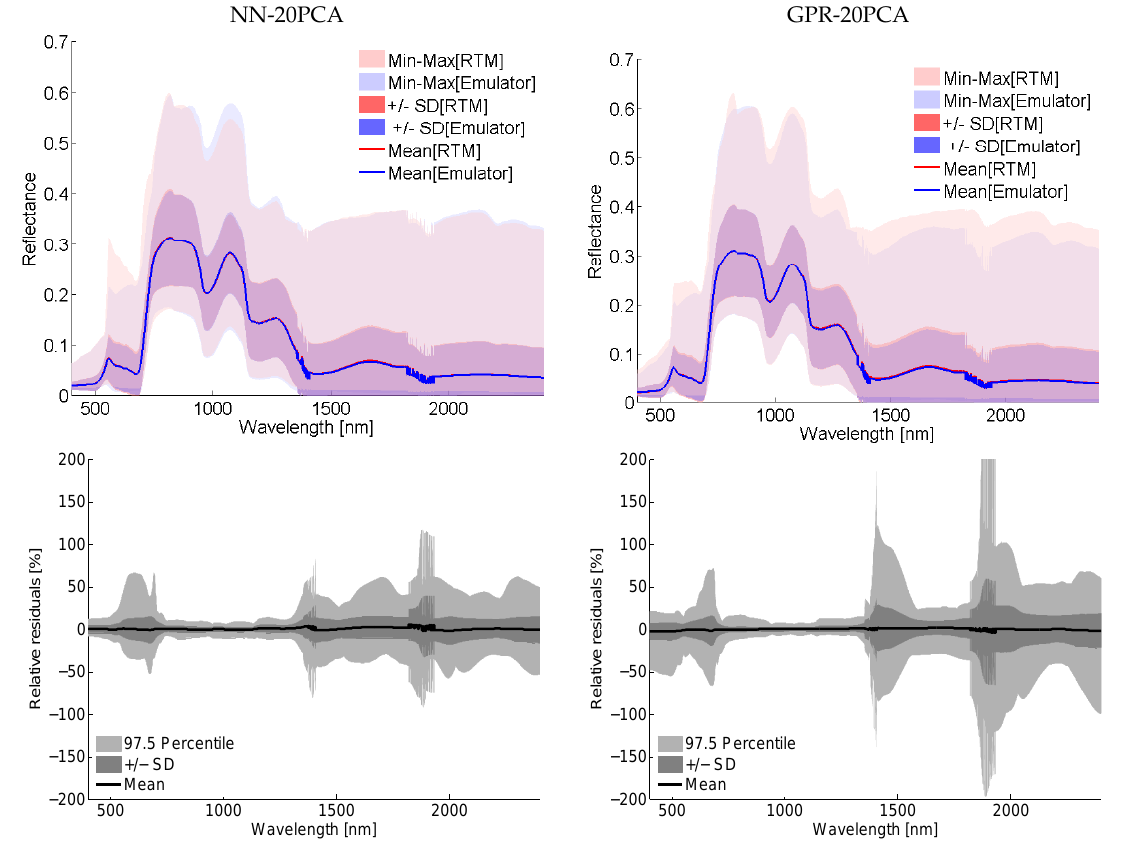
Figure 2. Top : General statistics (mean, standard deviation (SD), min-max) for SCOPE validation and corresponding emulated R spectra using SCOPE500-NN-20PCA (left) and SCOPE500-VHGPR-20PCA (right) emulators. The SD and min-max boundaries areas are presented as semi transparent so that their shapes for both datasets can be distinguished (red: RTM, blue: emulator). Consequently, the blended purple (SD) and pink (min-max) colors indicate the degree of RTM vs. emulated data overlapping. Bottom : Relative residuals between SCOPE and emulated R spectra. The areas represent the maximal spectral difference (light gray) and 1 SD (dark gray) for the 97.5 percentile. The black line represents the mean spectral